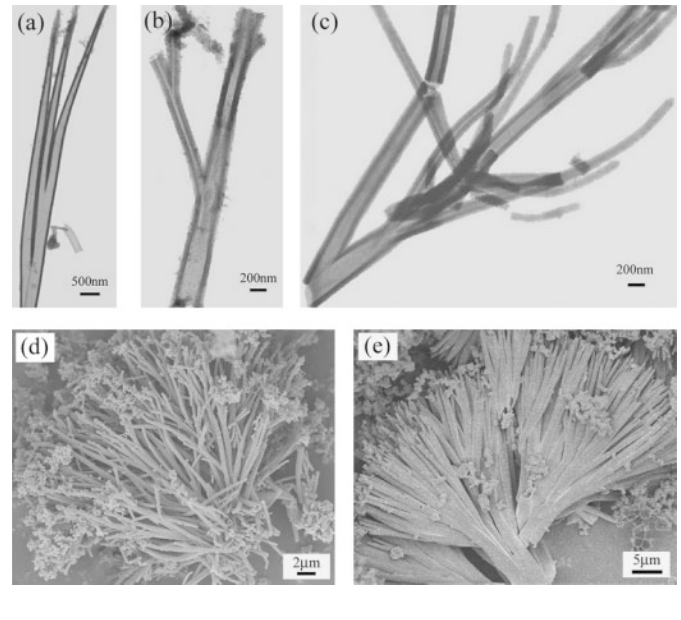
Figure 3. Conductive polymer nanotube junctions and their aggregated dendrites fabricated using non-templating (self-assembly) method: a-c ) transmission electron microscopy (TEM) and d ) scanning electron microscopy (SEM) image of Polyaniline nanotube junctions; e ) SEM image of Polypyrrole dendrite. Reproduced with permission from Wiley-VCH Verlag